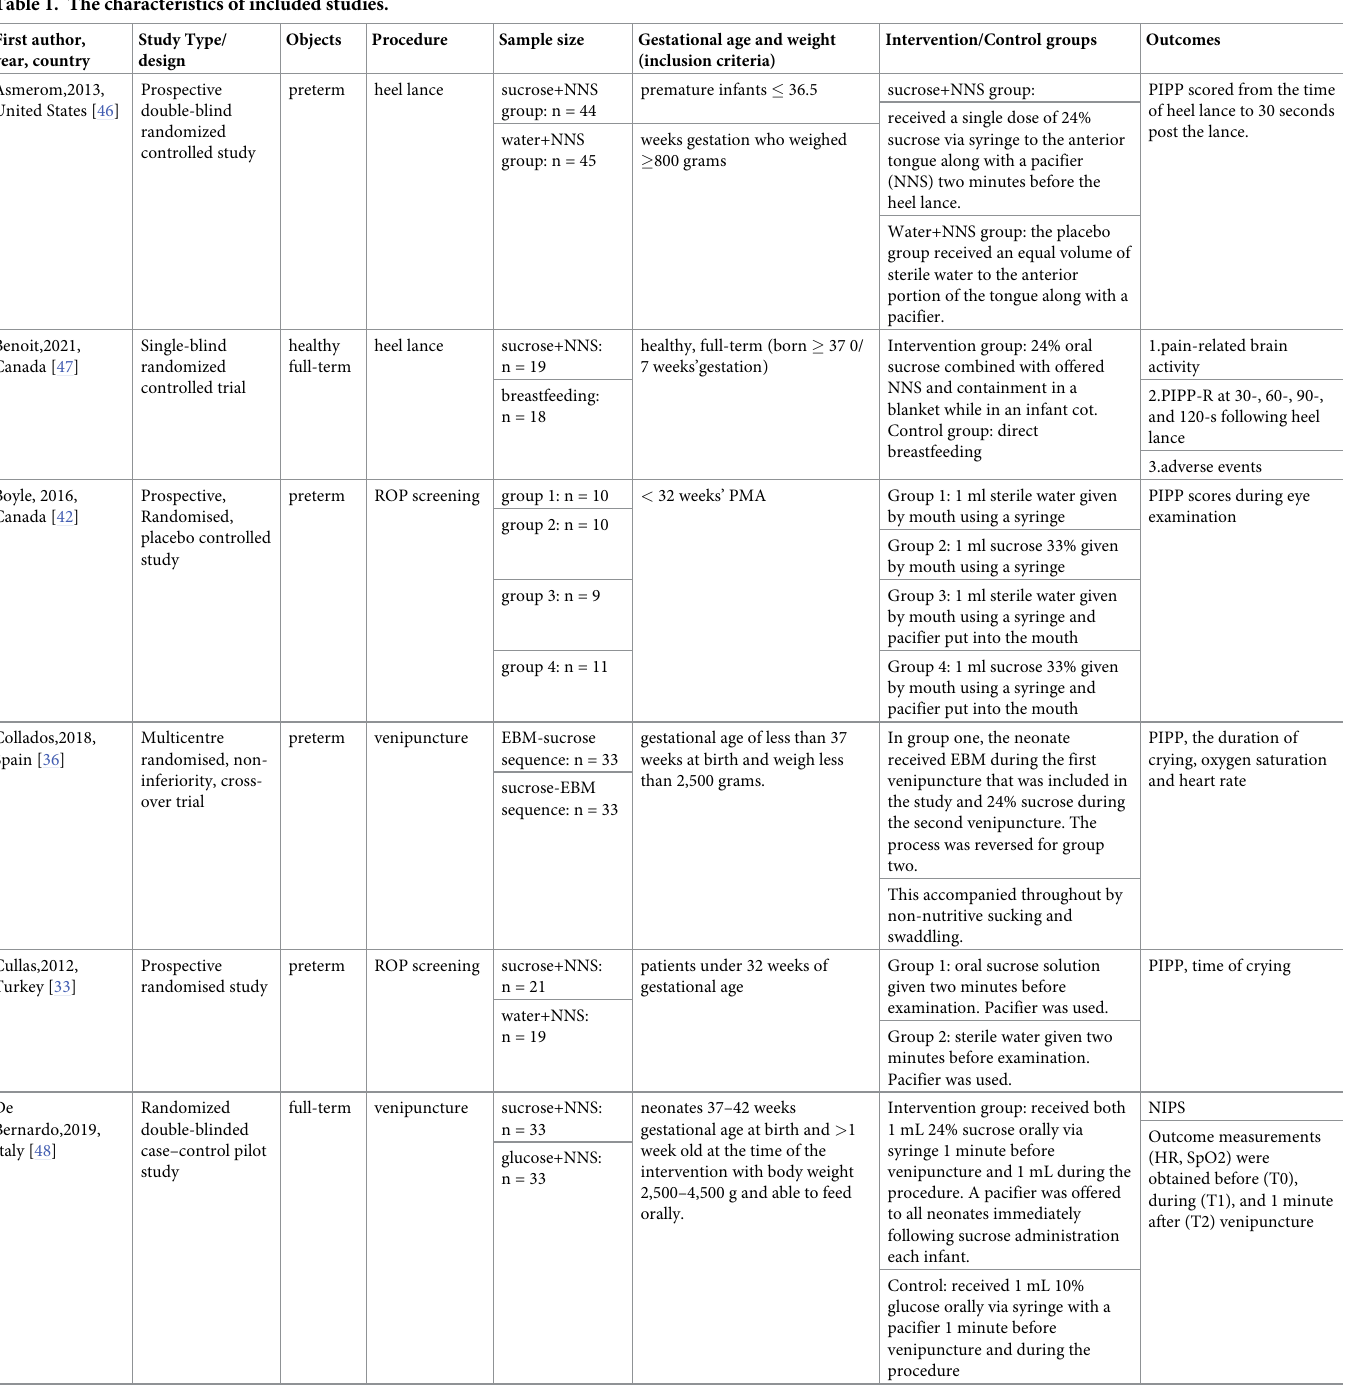
Table 1. The characteristics of included